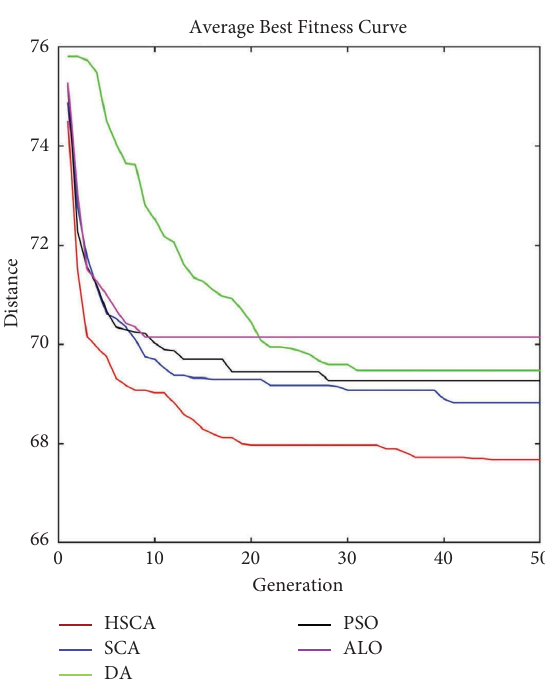
Figure 9: Optimal average values were obtained with diferent algorithms after 20 runs in case study